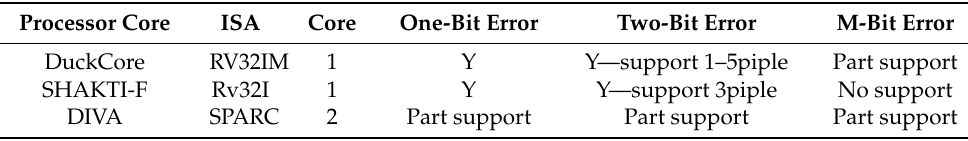
Table 5. Comparison of different processor core